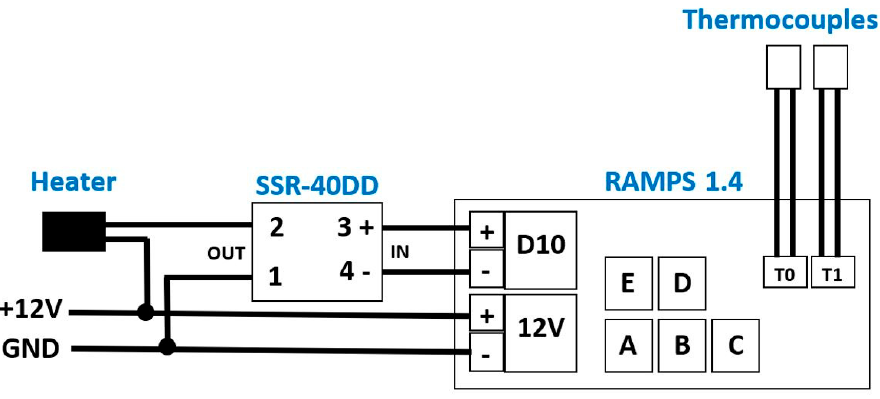
Figure 2. Hybrid printer wiring diagram.